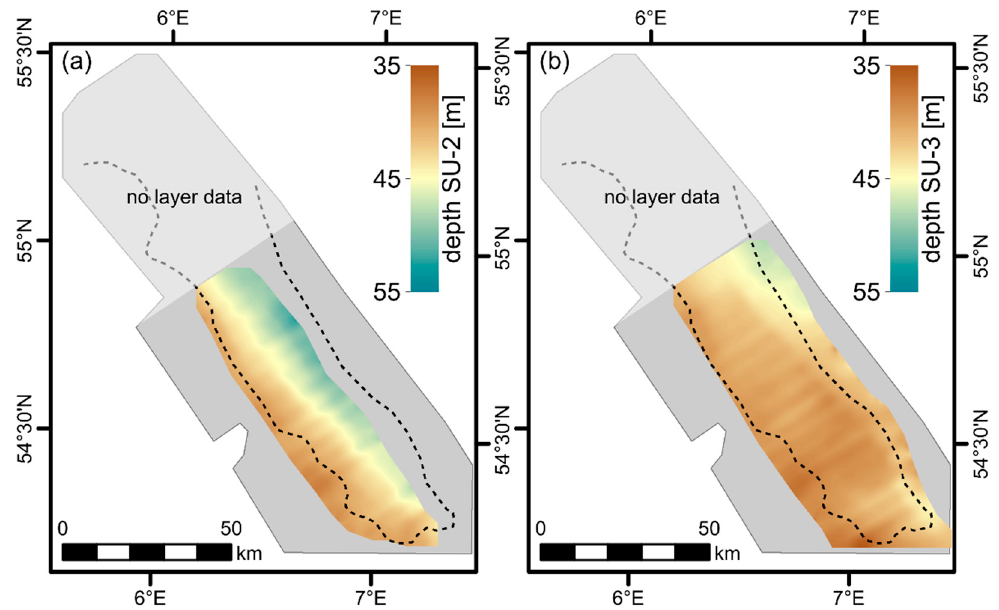
Figure 5. Depth of distinct seismic reflectors representing the upper boundary of seismic units. ( a ) Top of SU-2 (SR-F) and ( b ) top of SU-3 (SR-G). Values were not calculated for the northern part of the valley because the density of data was lower and reliable identification of the seismic reflectors was more difficult.